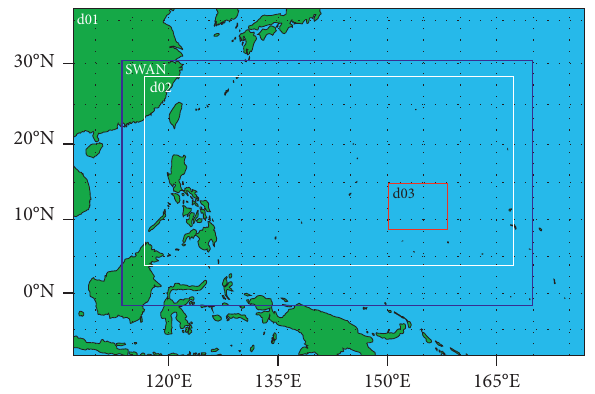
Figure 2: Model domains configuration. The outermost is the domain of D01, the white box represents the domain of D02, the red box represents the initial position of vertex-following nest D03, and the blue box represents the domain of